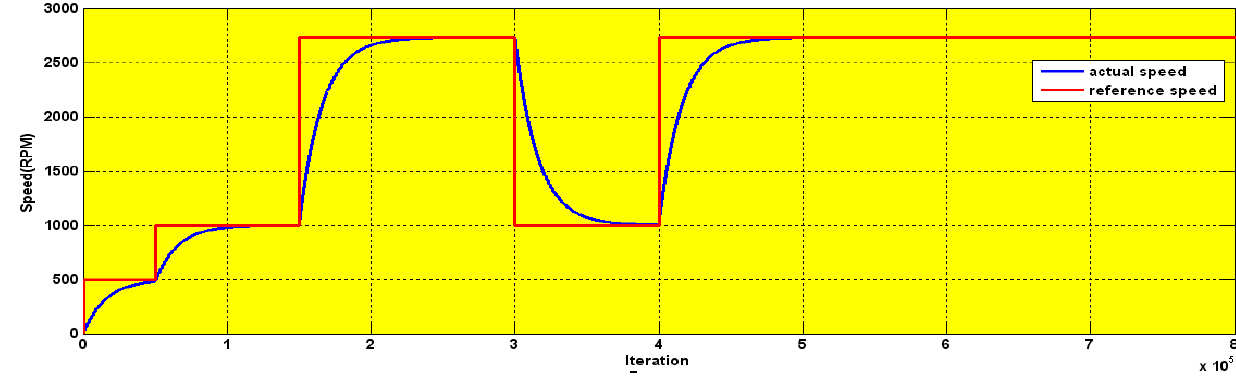
Figure 6. Simulation results of the speed tracking by the BMRAS.